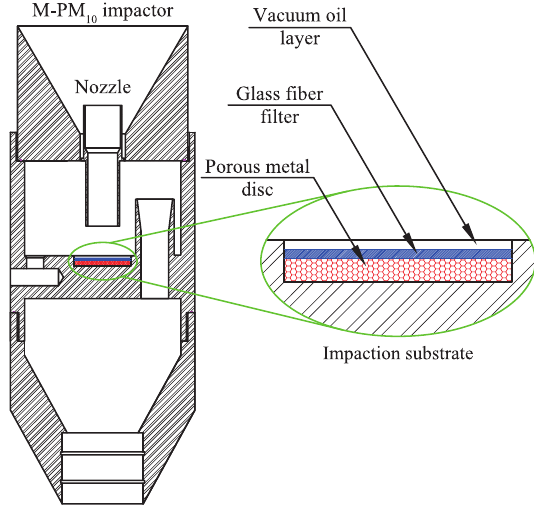
Fig. 2 Schematic diagram of the M-PM 10 impactor (Le T.C. et al., 2019).